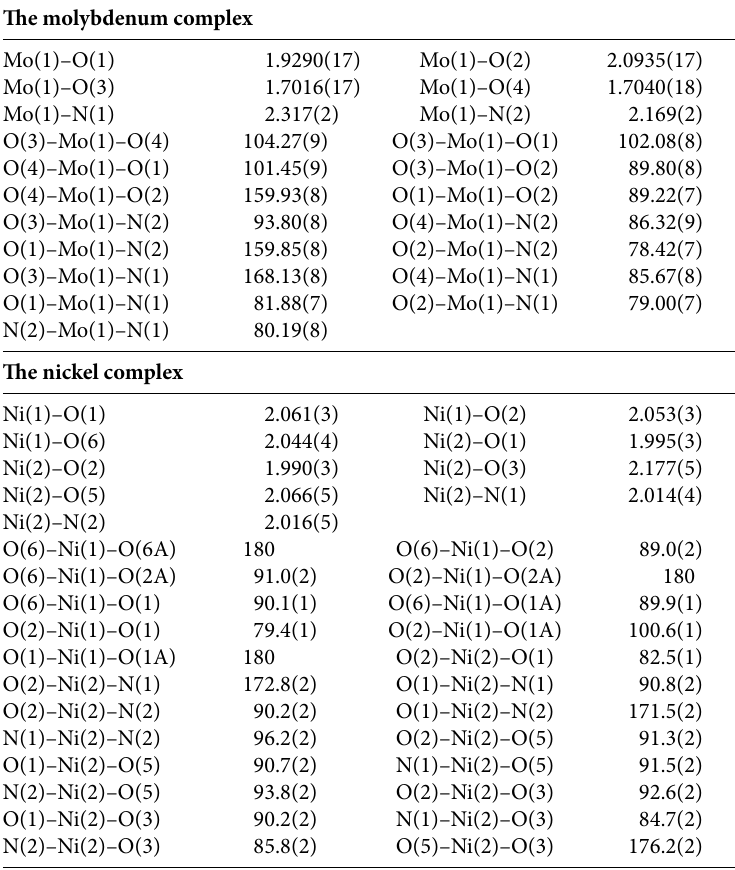
Table 2. Selected bond lengths (Å) and angles (°) for the complexes The molybdenum